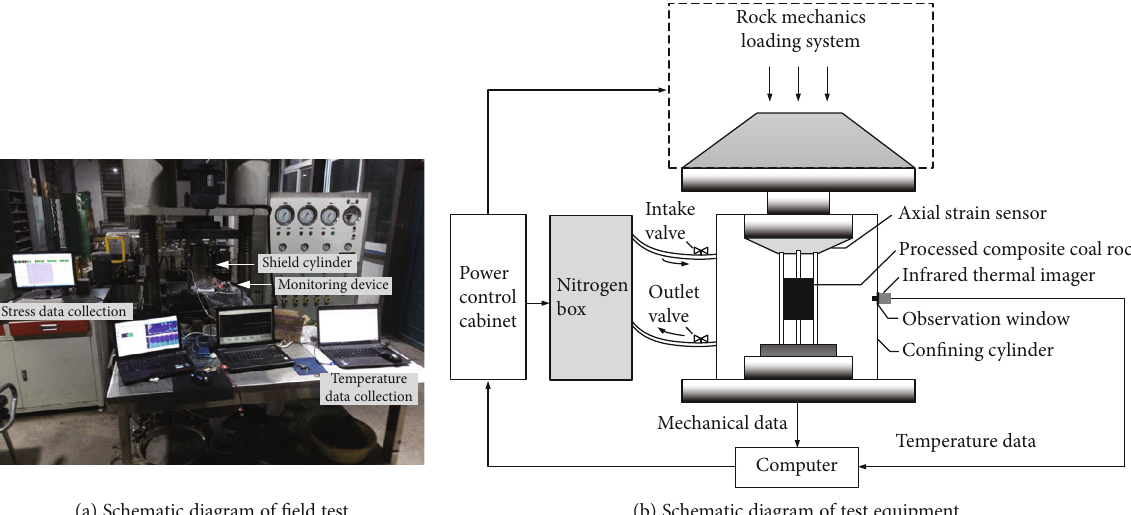
Figure 7: Schematic diagram of test equipment and fi eld test. Figure 7(a) is the schematic diagram of the fi eld test, and Figure 7(b) is the schematic diagram of the test equipment. The test equipment is mainly composed of a triaxial test machine, a power control cabinet, a nitrogen box, an infrared thermal imager, and a computer. Power is supplied by the power control cabinet during the experiment. The inlet valve and outlet valve of the nitrogen tank are responsible for controlling the pressurization of the processed composite coal-rock. An observation window is set on the shielding cylinder of the three-axis testing machine, and an infrared thermal imager is placed here to collect the T ave data of the samples. The mechanics and temperature data are uniformly transmitted to the computer for display and storage.